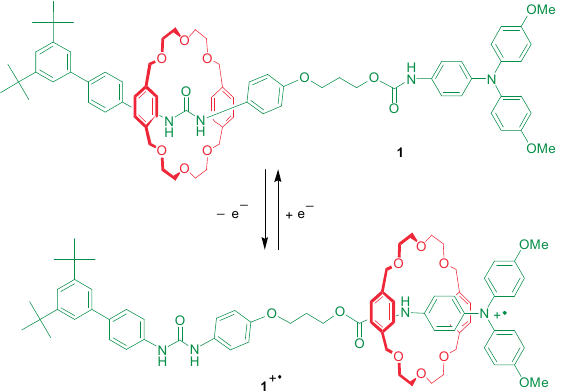
Scheme 3. Redox-based switching of the [2]rotaxane 1